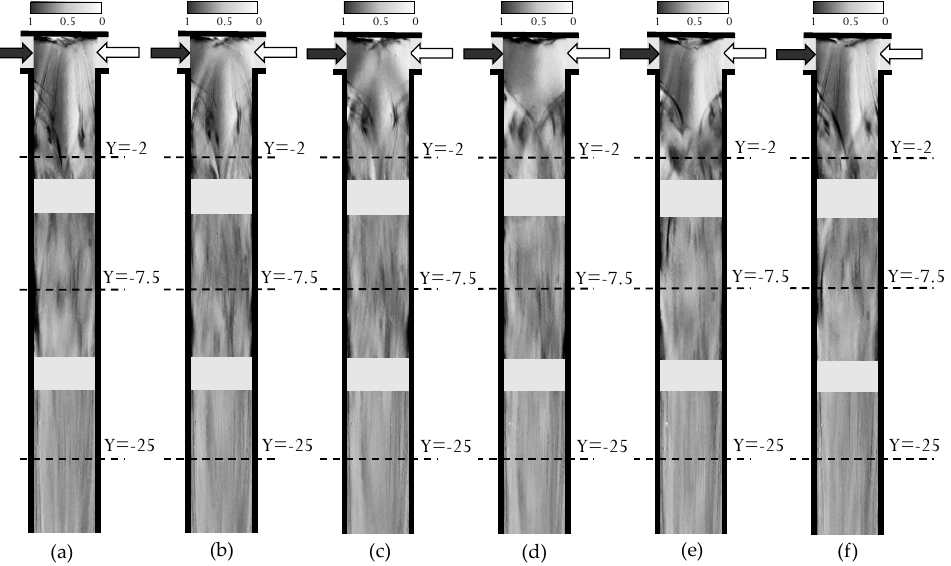
Figure 3. Experimental depth-averaged MB + concentration at Re = 320, for instants: ( a ) t / τ = 0, ( b ) t / τ = 0.17, ( c ) t / τ = 0.33, ( d ) t / τ = 0.5, ( e ) t / τ = 0.67, ( f ) t / τ =